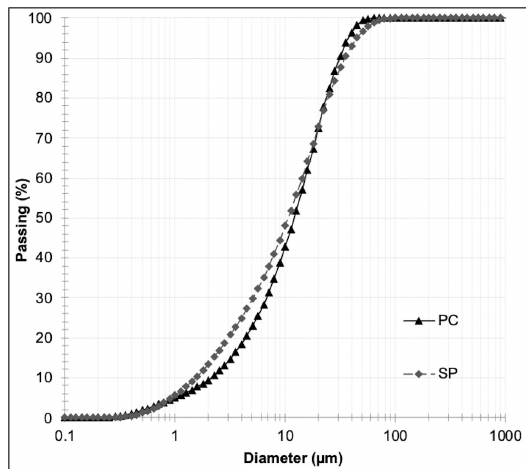
Figure 1. Particle size distribution of PC and